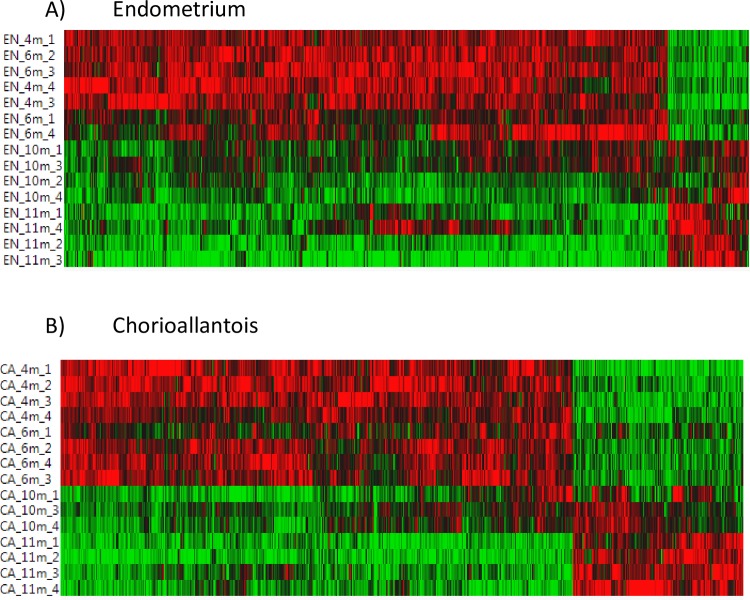
Heat map of endometrium and chorioallantois.Clustered heat map showing relative gene expression / sample for all differentially expressed genes (FDR P-Value < 0.05) at each gestational age. Includes A) endometrium, excluding diestrus and B) chorioallantois at 4, 6, 10 and 11 m gestation.